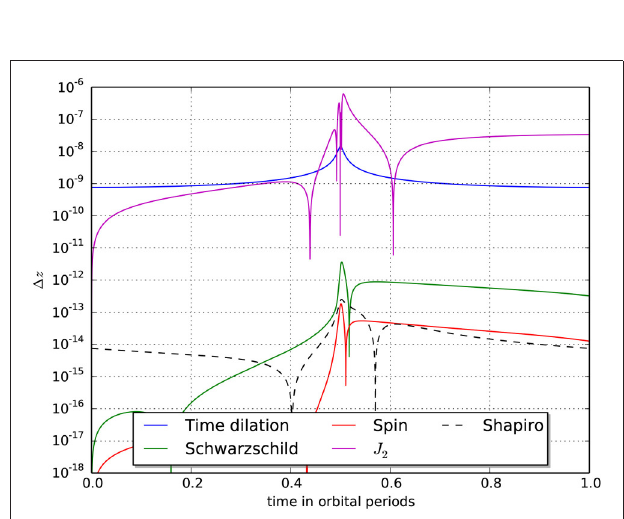
FIGURE 5 | Higher order relativistic effects for Cassini .